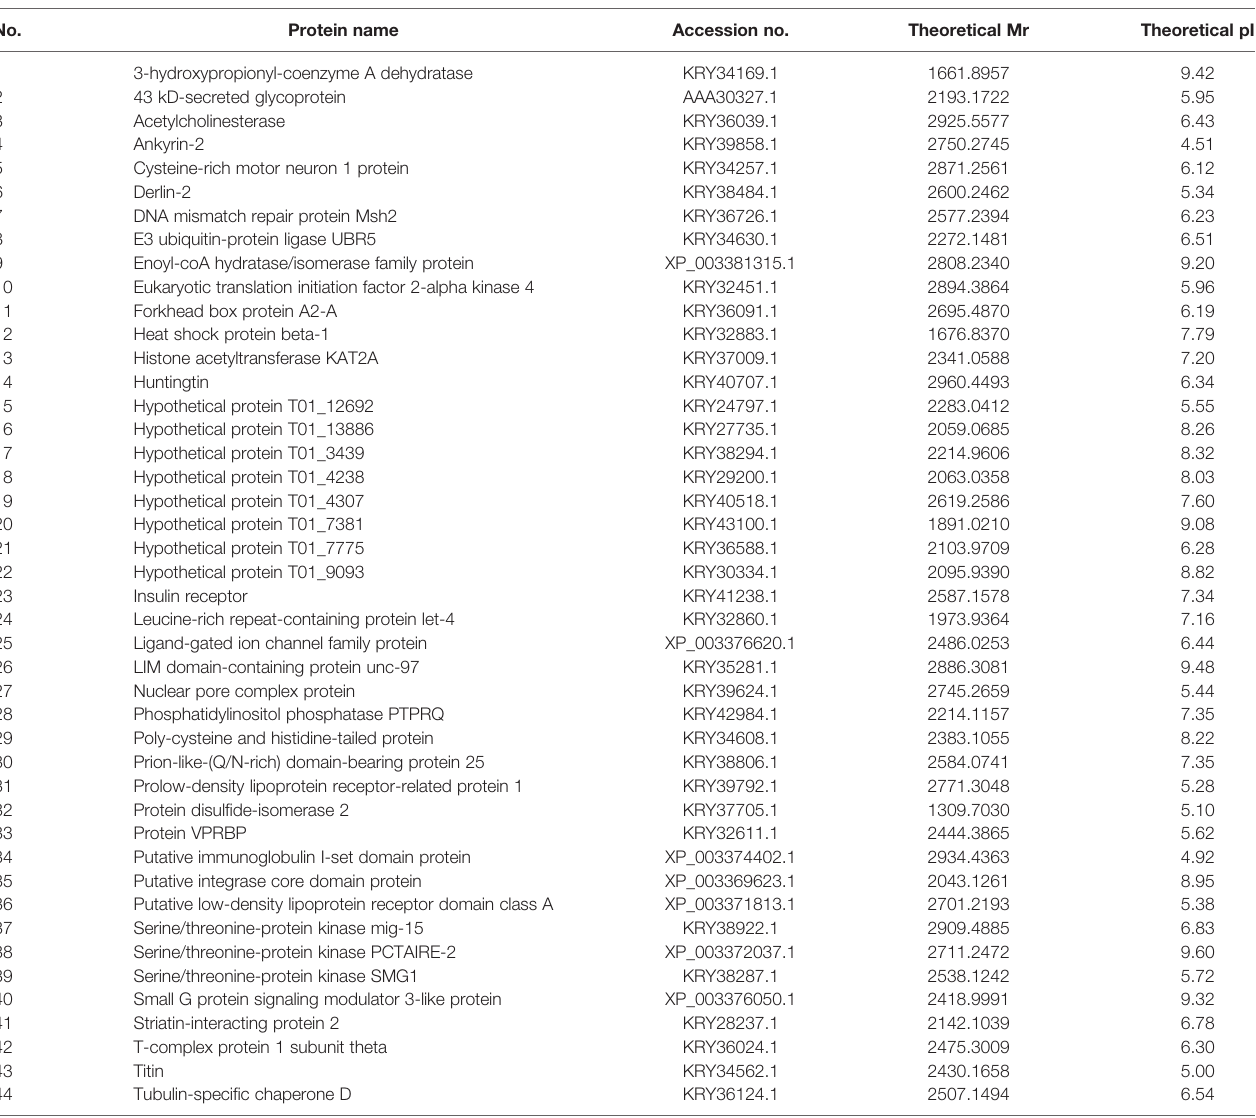
TABLE 1 | Forty-four different proteins of muscle larval extract (LE) that hit to Trichinella spiralis proteins.